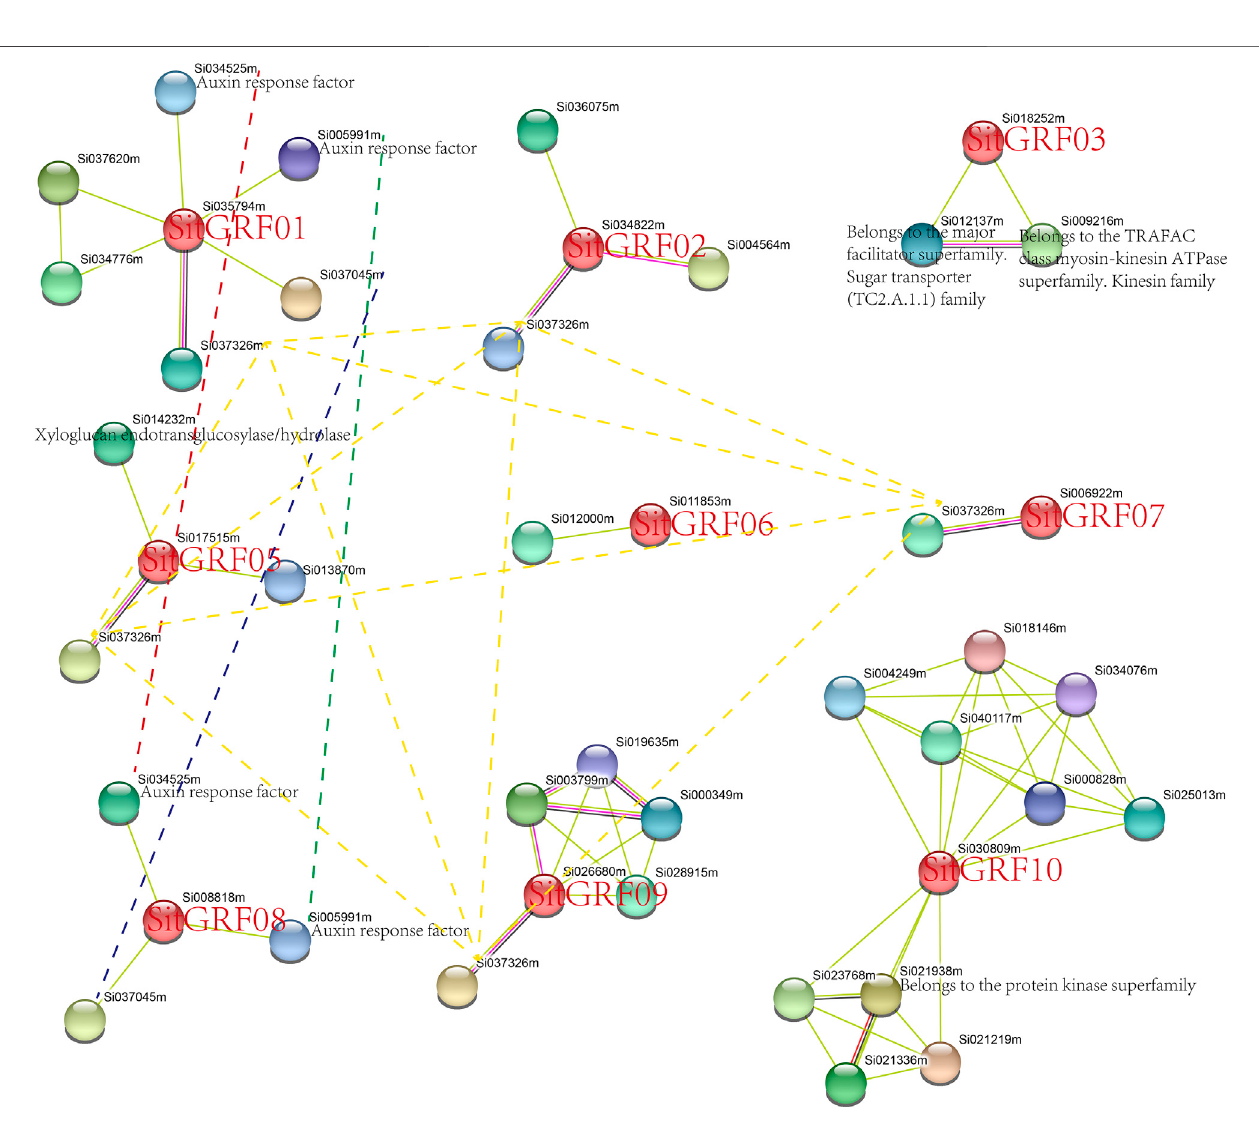
FIGURE 11 | Protein interaction analysis offoxtail millet GRFs. The same protein is connected by a dotted line. The unannotated protein indicates uncharacterized protein in the String database.